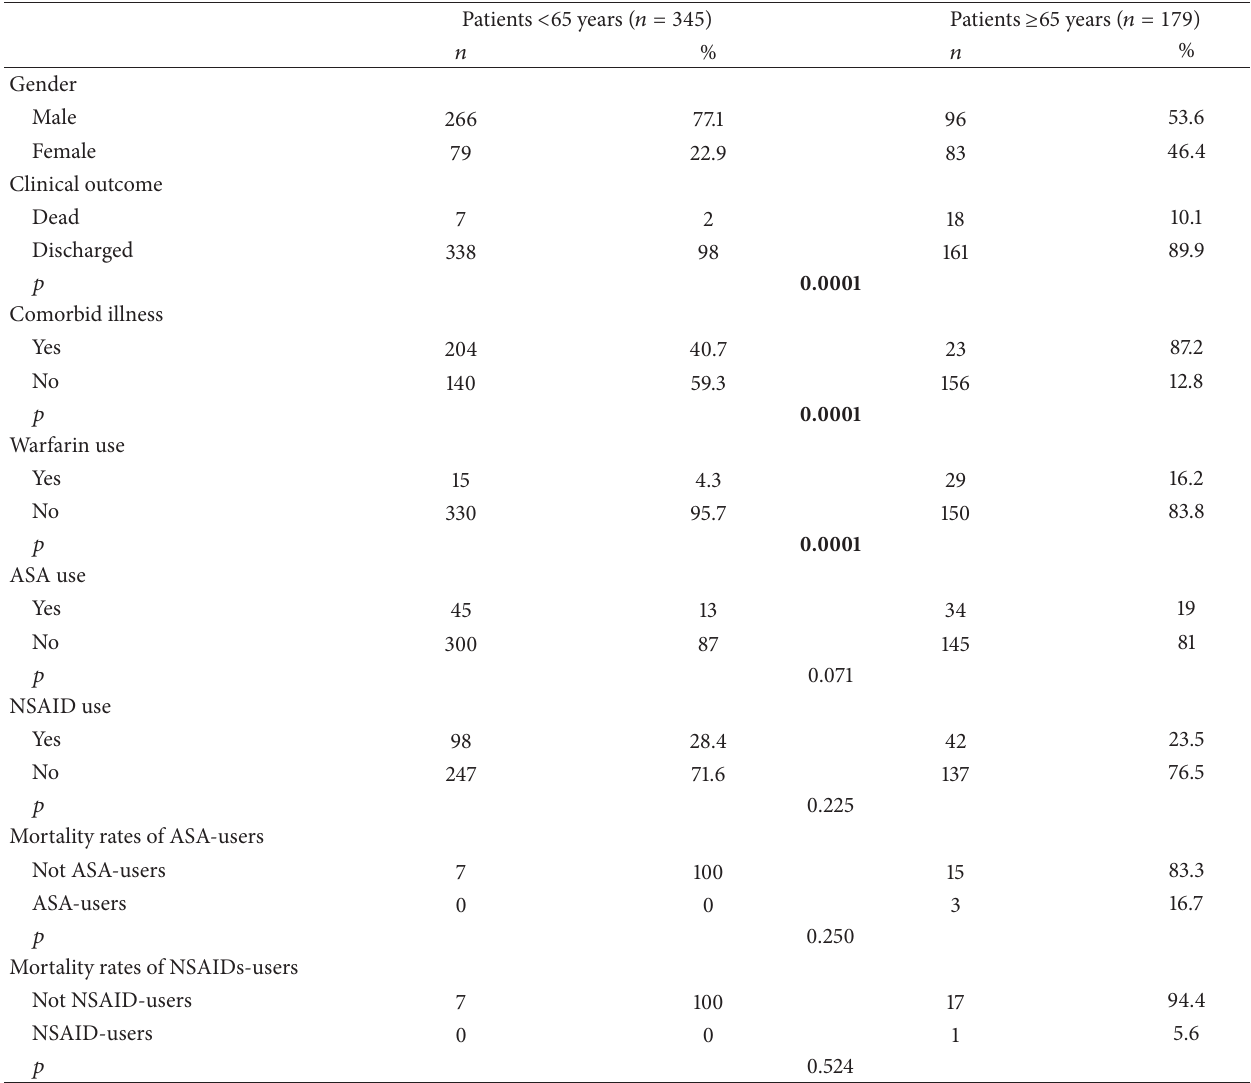
Table 2: Comparison between patients < 65 years and patients ≥ 65 years in regard to gender, clinical outcome, comorbid illness, ASA and NSAID use, and